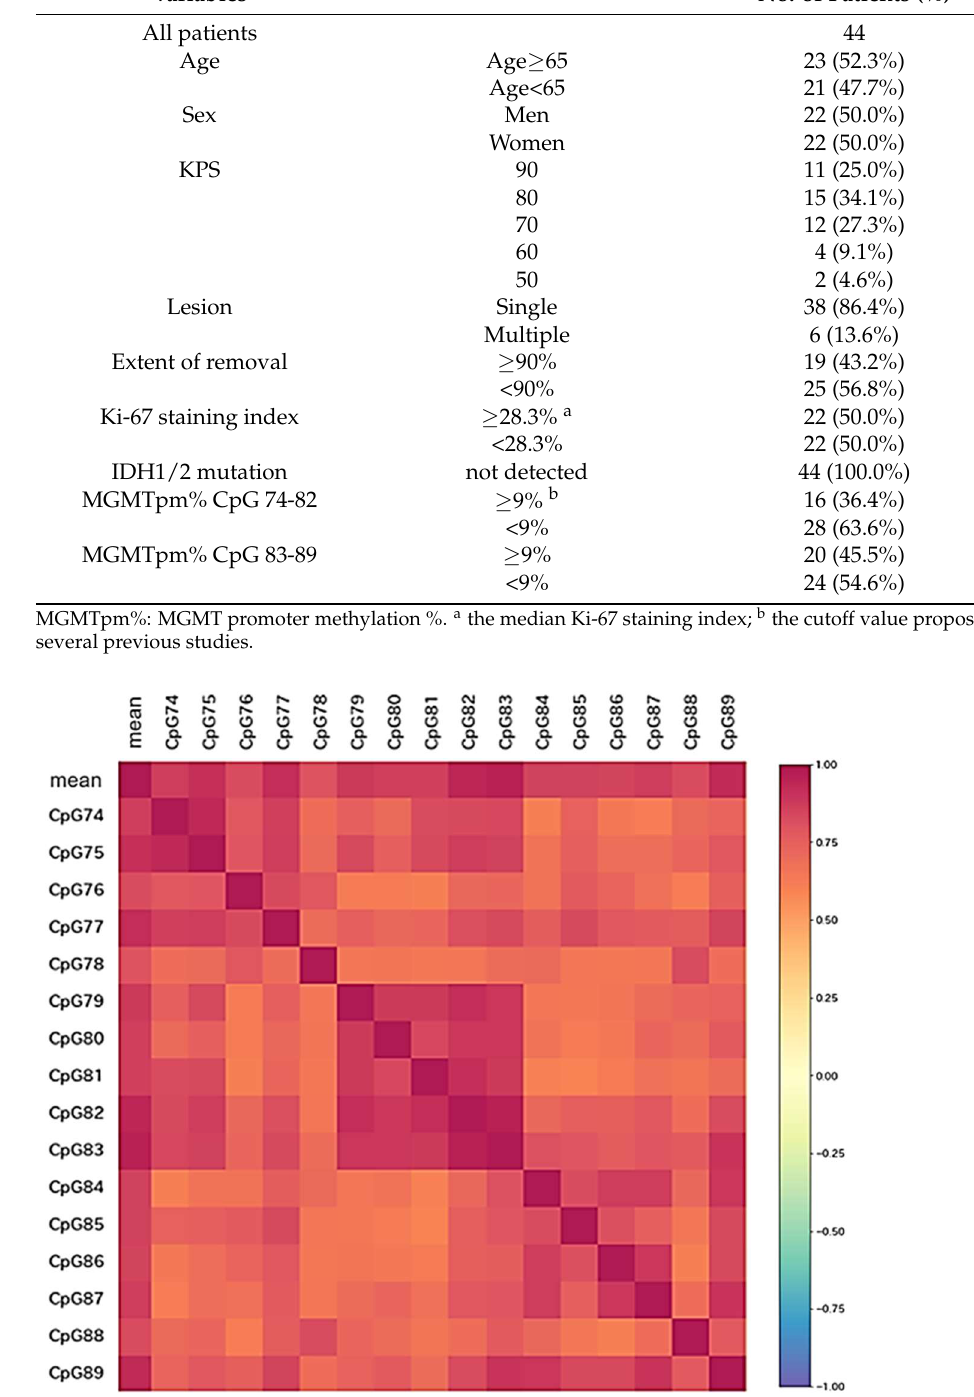
Figure 1. A heatmap shows correlation coefficients among methylation levels of all CpG sites and the average. CpG sites within the range from 79 to 83 shows a strong